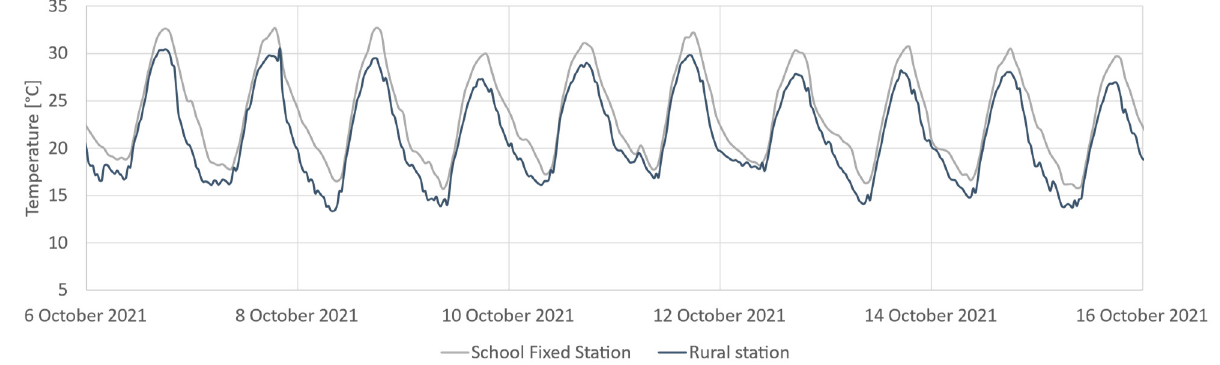
Figure 4. Hourly temperatures were measured by the rural station “La Rinconada” and the school fixed station.